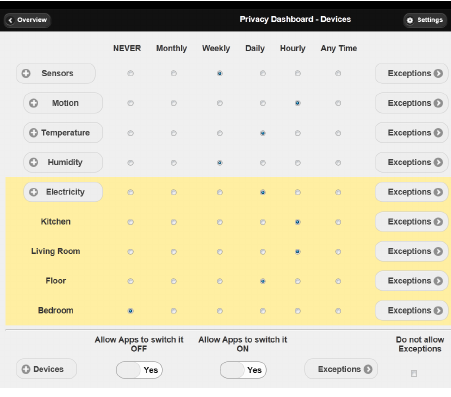
Figure 7: Privacy